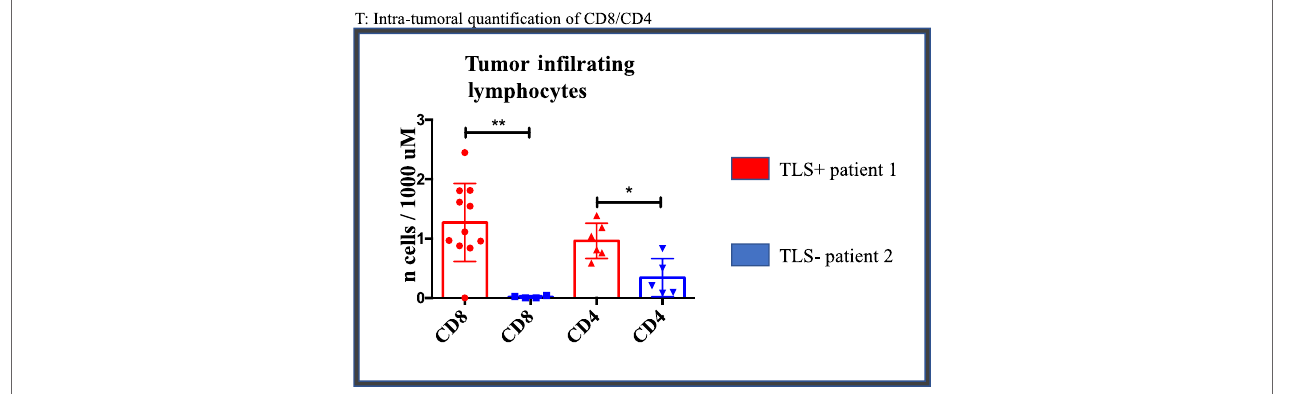
FigUre 1 | Immune infiltrate in MBC (patient 1, P1) and basal breast carcinoma (patient 2, P2). Serial histological samples of P1 and P2 were stained with routine markers. Stainings showed the following repartition: estrogen receptor [ (a–K) ER: P1 − , P2 − ], progesterone receptor [ (B–l) PR: P1 − , P2 − ], human epidermal growth factor 2 [ (c–M) HER2: P1 − , P2 + ], Ecadherin [ (D–n) Ecadh: P1 + , P2 + ], P1 − , P2 − ], and Ki67 [ (e–O) : P1 30% in tumor and tertiary lymphoid structures (TLS); P2 5% in tumor and 0% in immune aggregates]. Additional staining with non-routine markers was performed. They allowed characterization of TLS in P1 but not in P2: B cells [CD20 (F–P) P1 germinal center, P2 scarce cells], CD4 T cells [CD4 (g–Q) P1: present in all compartments; P2: non organized], CD8 T cells [CD8 (h–r) P1: restricted to the TLS periphery and invading the tumor; P2: rare in the aggregates and absent in the tumor]. IF recapitulating the key immune components, including PD1, FoxP3 CD8, and tumor cytokeratine + are shown in (i) and (s) . PD1 + cells are absent in P2. (T) Intra-tumoral number of CD8 and CD4 cells in P1 and